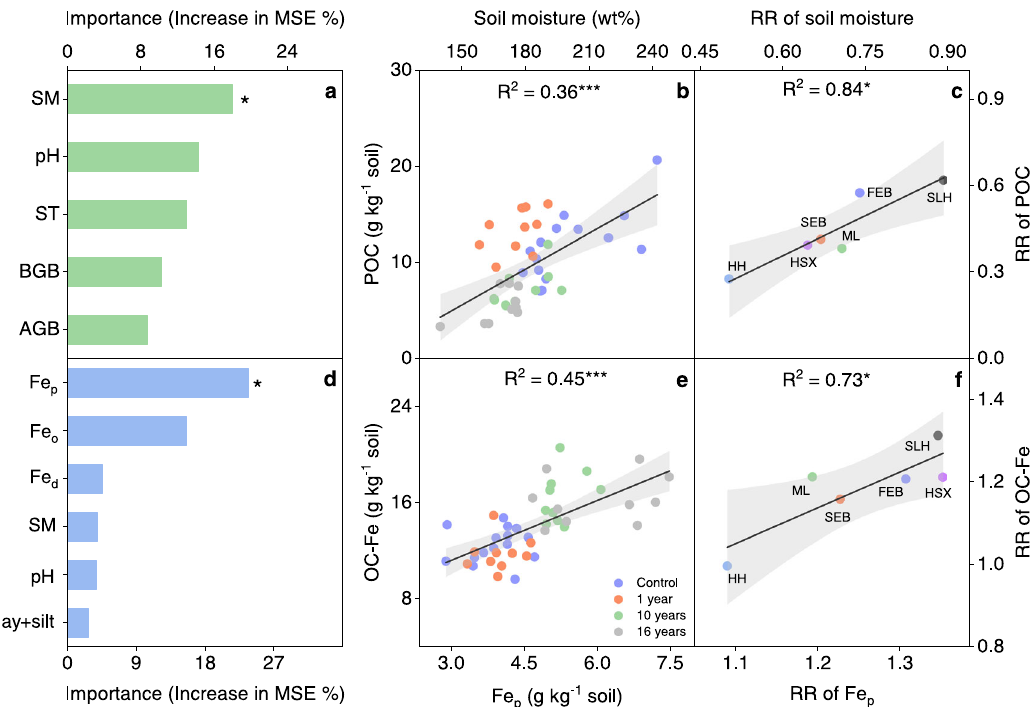
Fig. 4 | Relationships of POC and OC-Fe contents with potential drivers. a , b Relativeimportanceof bioticand abioticvariablesinin fl uencing POCrevealed by random forest model ( a ) and relationshipofPOCcontent with soil moisture ( b ) along the thaw sequence. c Relationship of response ratio (RR, the ratio of two variables between collapsed and control plots [Variable collapse /Variable control ]) of POCwithRRofsoilmoistureacrosstheSLH,FEB,SEB,ML,HSX,andHHsitesonthe TibetanPlateau. d , e RelativeimportanceofedaphicvariablesandvariousFeoxides in affecting OC-Fe ( d ) and association between OC-Fe and Fe p ( e ) along the thaw sequence. f Linkages of RR of OC-Fe with RR of Fe p . POC, particulate organic